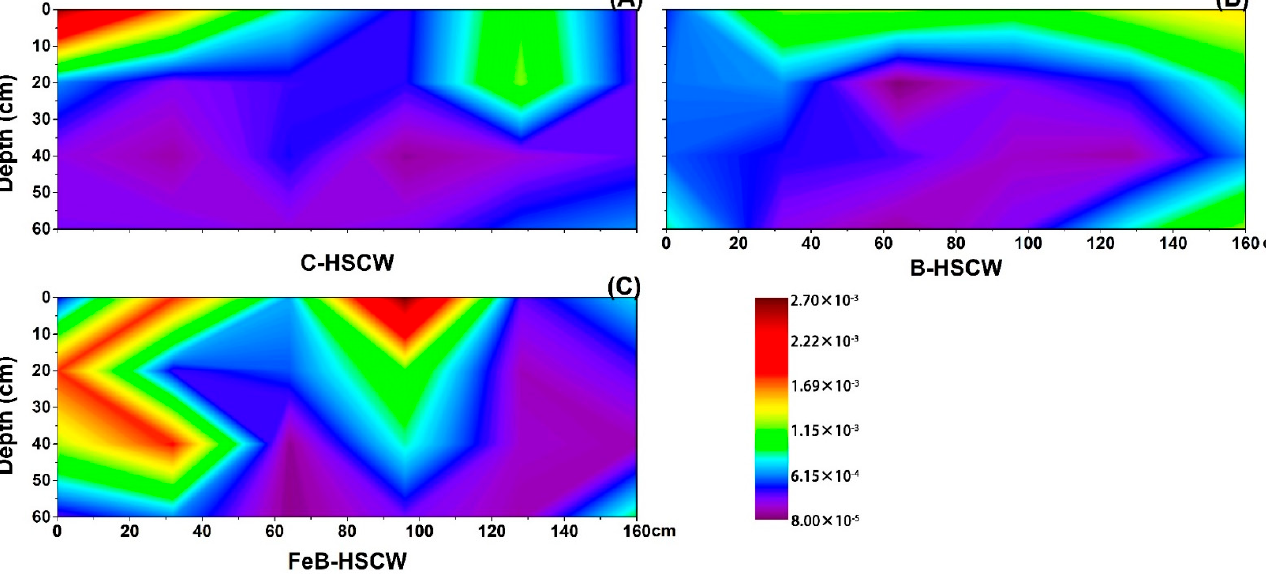
Figure 7. The spatial distribution of nirK relative abundance in C-HSCW ( A ), B-HSCW ( B ), and FeB-HSCW ( C ) based on interpolated maps. Color scales indicate extrapolated values by kriging. C-HSCW, without biochar and FeB-modified biochar; B-HSCW, with biochar; FeB-HSCW, with FeB-modified biochar.